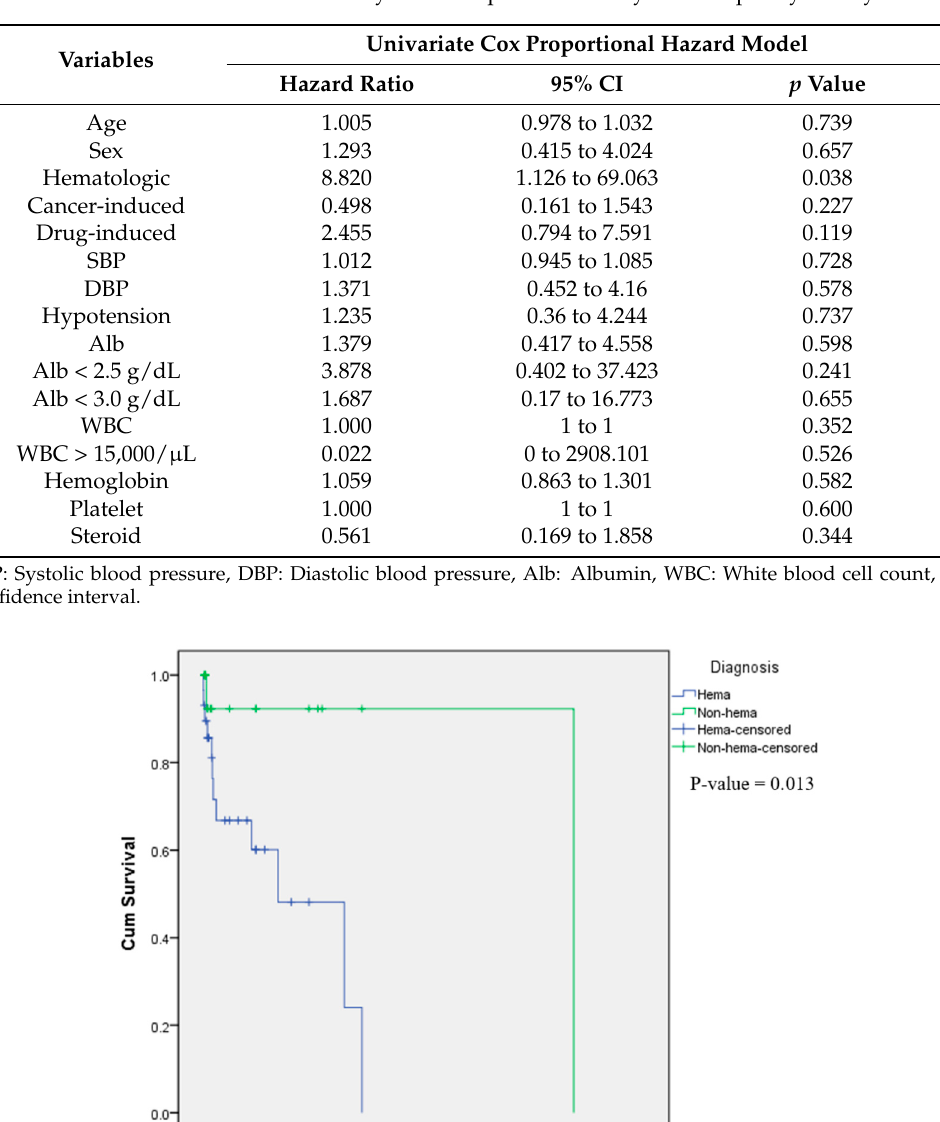
Table 6. Factors associated with mortality in cancer patients with systemic capillary leak syndrome.